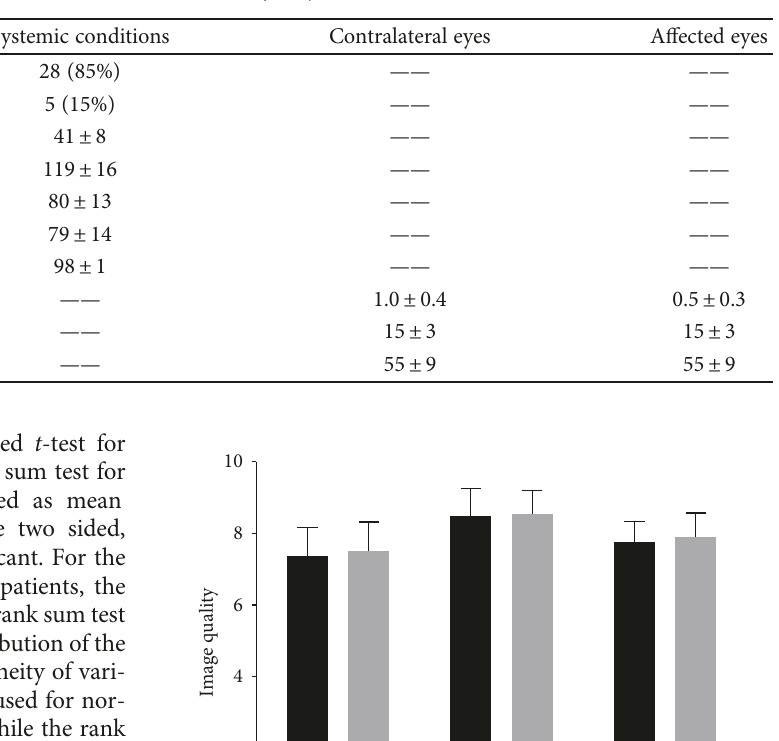
Table 1: Characteristics of the study subjects.